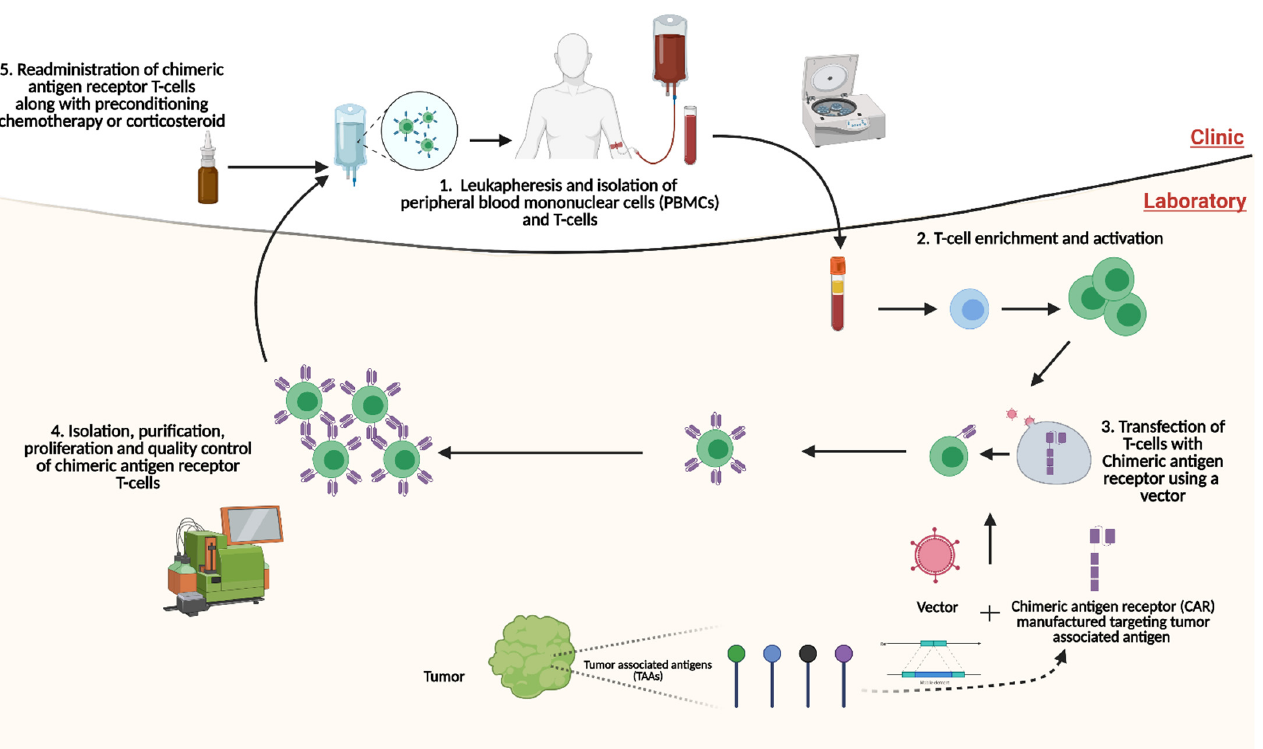
Figure 1. Platform of autologous administration of chimeric antigen receptor T-cell (CAR-T) ther- apy. Through leukapheresis, T-cells are isolated, activated and enriched. CARs targeting TAAs are synthesised and transfected into T-cells through a vector. Following this, CAR-T cells are isolated, purified and proliferated. CAR-T cells are then readministered to the patient, typically after the pa- tient has had preconditioning treatment with either a steroid or chemotherapy. CAR: chimeric anti- gen receptor; PBMCs: peripheral blood mononuclear cells; TAAs: Tumour-associated antigen. Cre- ated with BioRender.com (accessed on 1 December 2021).